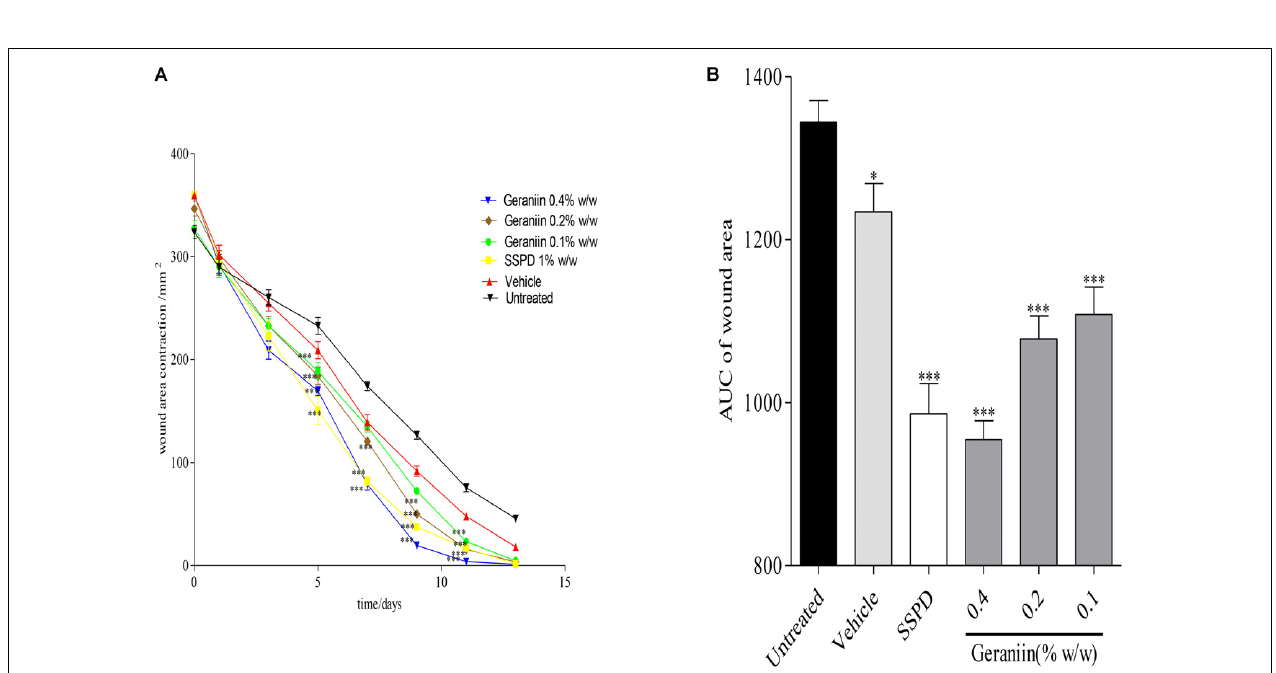
FIGURE 2 | Influence of geraniin on rate of wound closure. Full thickness wounds of approximately 20 mm in diameter were excised on the dorsal region of rats. The excised wounds were topically treated with geraniin (0.1, 0.2, and 0.4% w/w) formulated as aqueous cream. Wound diameter was measured on days 1, 3, 5, 7, 9, 11, and 13 post injuries. (A) Time-course curve, (B) AUC of time course curve. Excised wounds were treated with 0.1, 0.2, and 0.4% w/w geraniin. Vehicle group was treated with aqueous cream base. SSPD: 1% w/w silver sulphadiazine-treated wounds. Values are mean ± SEM, n = 5. ∗∗∗ p < 0.001; ∗∗ p < 0.01; ∗ p < 0.05 compared to untreated group (two-way ANOVA followed by Bonferroni’s post hoc test).